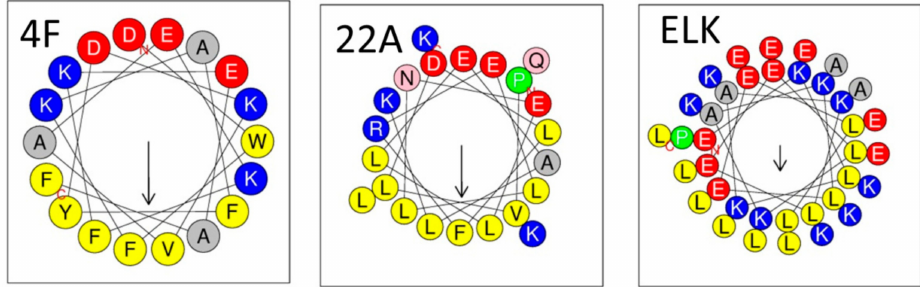
Figure 4. Helical wheel analyses of some of the most prominent representatives of apo-AI mimetic peptides. The peptides belong to class A amphipathic helices [55]. The hydrophobic and hydrophilic residues are grouped on opposing faces with the negatively charged residues being aligned